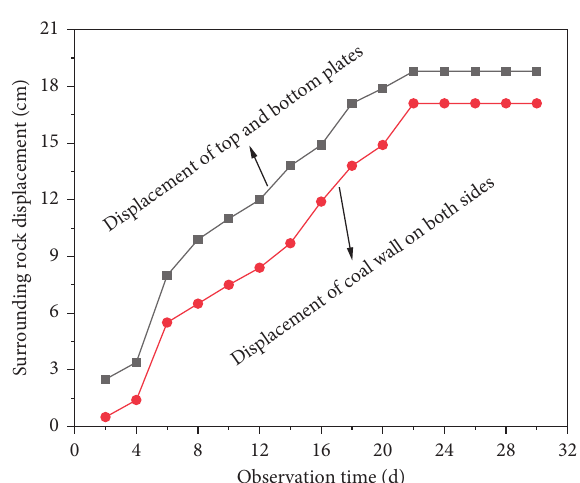
Figure 16: Shape variation of the surrounding rock around the crossheading.